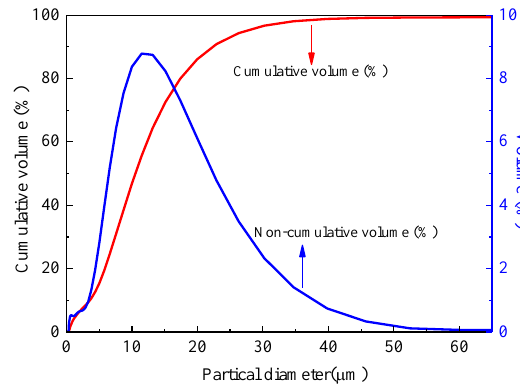
Figure 1. Granulometric analysis of kaolin powders.